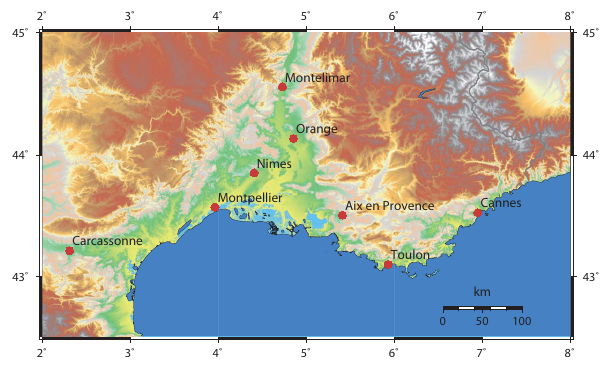
Fig. 1. Map of the studied region. The red dots indicate the loca- tions of the surface weather stations from which wind speed, tem- perature and rainfall data are